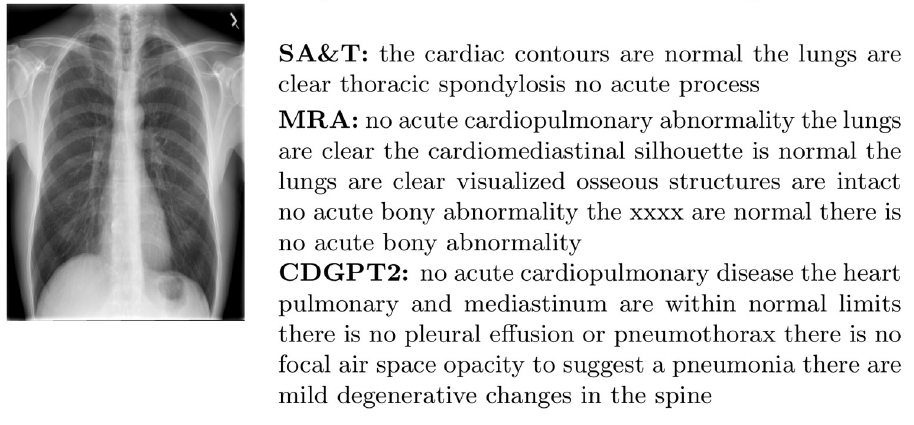
Fig 6. Example of reports generated with encoder-decoder methods. We show SA&T, MRA, and CDGPT2 outputs for an input image in the IU chest X-ray test set, and the reference ground truth report.